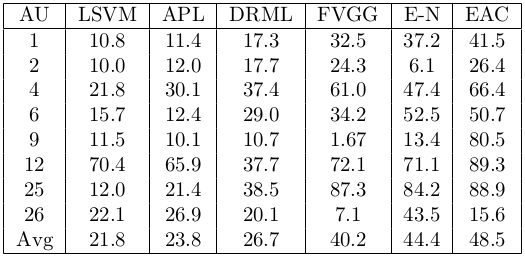
Table from the paper: EAC-Net: A Region-based Deep Enhancing and Cropping Approach for Facial Action Unit Detection
Table text:
AU
LSVM
APL
DRML
FVGG
E-N
EAC
1
10.8
11.4
17.3
32.5
37.2
41.5
2
10.0
12.0
17.7
24.3
6.1
26.4
4
21.8
30.1
37.4
61.0
47.4
66.4
6
15.7
12.4
29.0
34.2
52.5
50.7
9
11.5
10.1
10.7
1.67
13.4
80.5
12
70.4
65.9
37.7
72.1
71.1
89.3
25
12.0
21.4
38.5
87.3
84.2
88.9
26
22.1
26.9
20.1
7.1
43.5
15.6
Avg
21.8
23.8
26.7
40.2
44.4
48.5